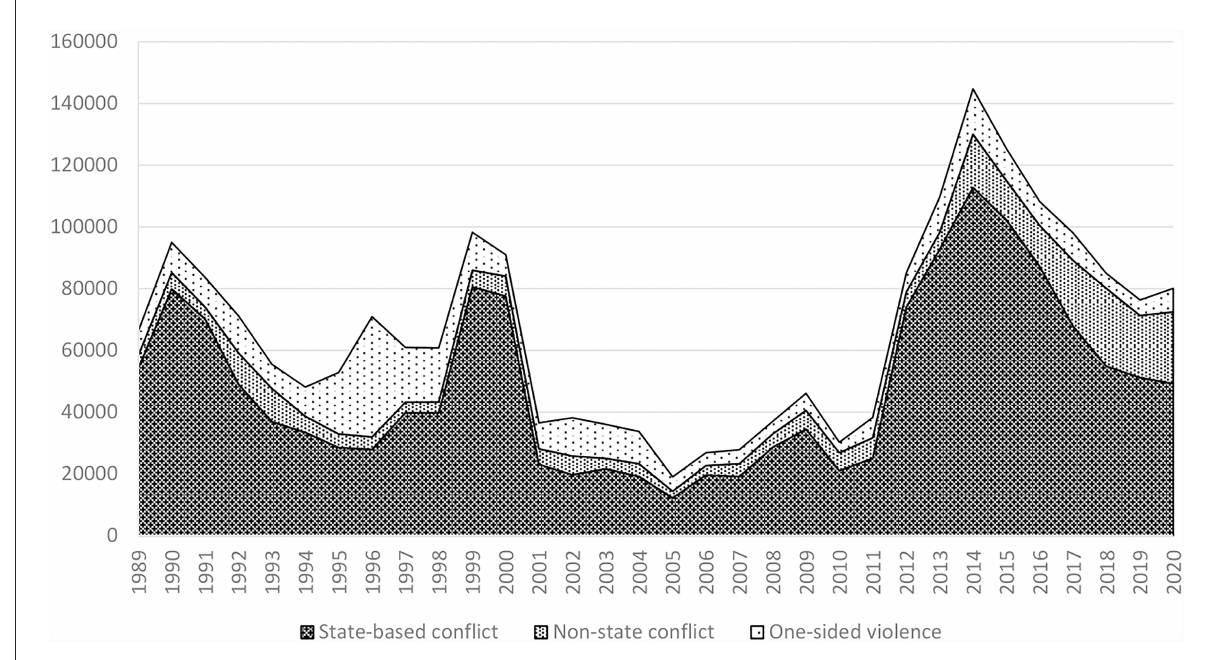
FIGURE1 Fatalities by type (world without Rwanda in 1994, 1989–2020). Source: Own elaboration based on https://ucdp.uu.se/downloads/charts/#